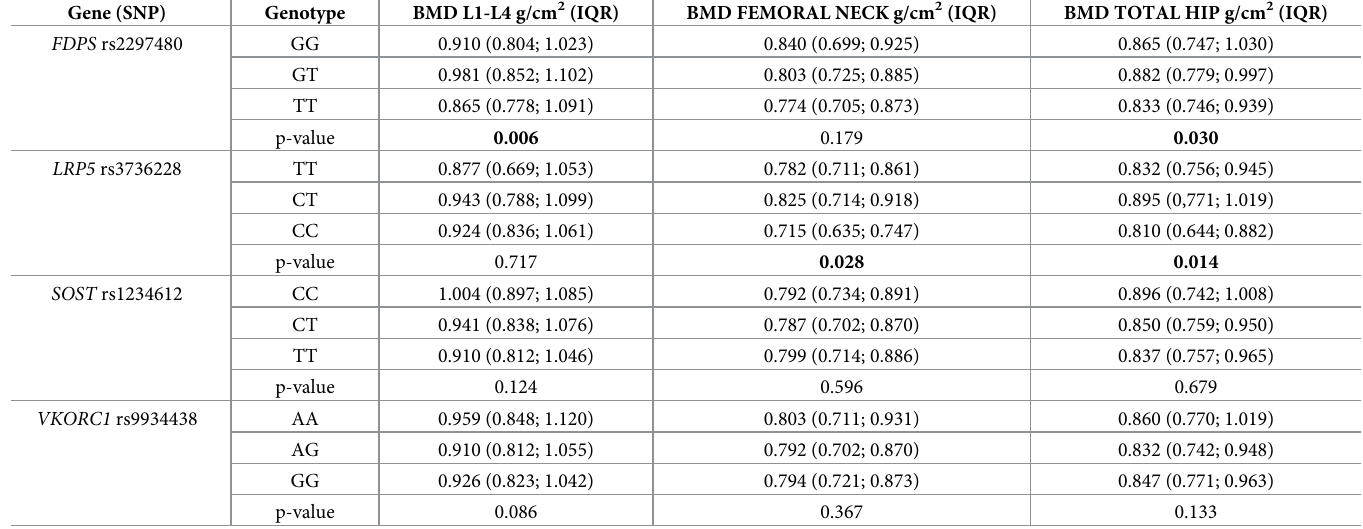
Women carrying the TT genotype of FDPS rs2297480 have significantly lower BMD values in the lumbar spine and total hip than the heterozygous GT or homozygous GG (p = 0.006 and p = 0.03, respectively), but not in the femoral neck (p = 0.179) (Table 3). After dividing the patients into groups, analysis of the codominant model was performed. Codominant models hypothesize that the major allele homozygotes, the heterozygotes or the minor allele homozygotes are associated with the lowest, the intermediate, and the highest risk, respectively, or they are associated with the highest, the intermediate, and the lowest risk, respectively. Results show that when analyzing the codominant model, the TT genotype of rs2297480 SNP continues to be significantly associated with OP risk (OR = 2.1; 95% CI = 1.4–3.3; p-value < 0.05), while the GT genotype had the lowest risk (OR = 0.4; 95% CI = 0.3–0.7; p-value = 0.001). Furthermore, the presence of the T allele was significantly associated with OP in the group analysis (p = 0.005) (Table 4). As for LRP5 rs3736228 SNP, the homozygous CC have significantly lower BMD values in the femoral neck and total hip than the CT or TT genotypes (p = 0.028 and p = 0.014), but not in the lumbar spine region (p = 0.717) (Table 3). In the codominant model of the groups analy- sis, this association continues to reach statistical significance in the OP group (OR = 1.5; 95% Table 3. Bone mineral density values among genotypes (n =